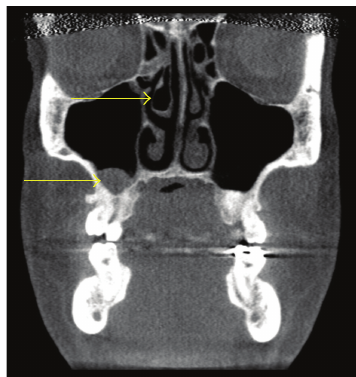
Figure 5: Coronal CT scans demonstrating bilateral middle concha bullosa (superior arrows) with bilateral maxillary sinusitis (inferior arrows). Note that there is more mucosal thickening on the left floor of the maxillary sinus than the right sinus floor, whereas the right concha bullosa demonstrates a greater degree of pneumatization compared to the left concha bullosa.